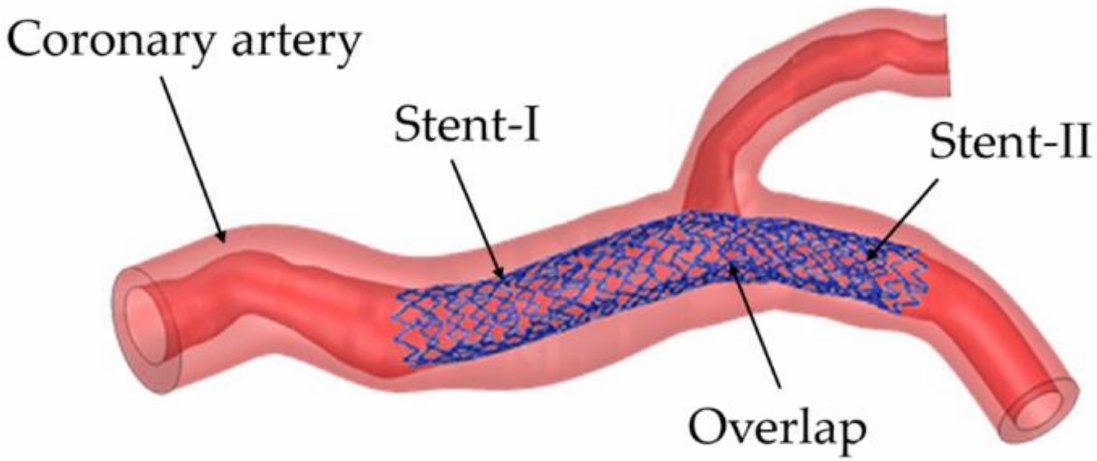
Figure 21. Implantation of two stents facing the target vessel